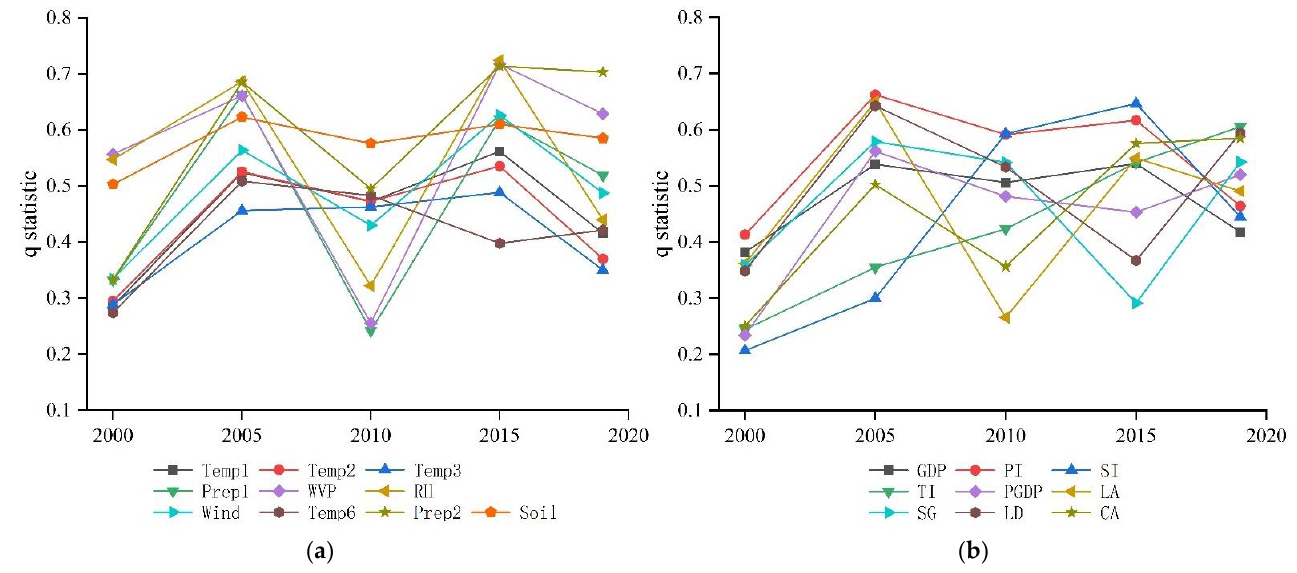
Figure 7. Interannual variation of driving factors with q statistic greater than 0.4. ( a ) Meteorologi- cal and environment factors; ( b ) anthropogenic